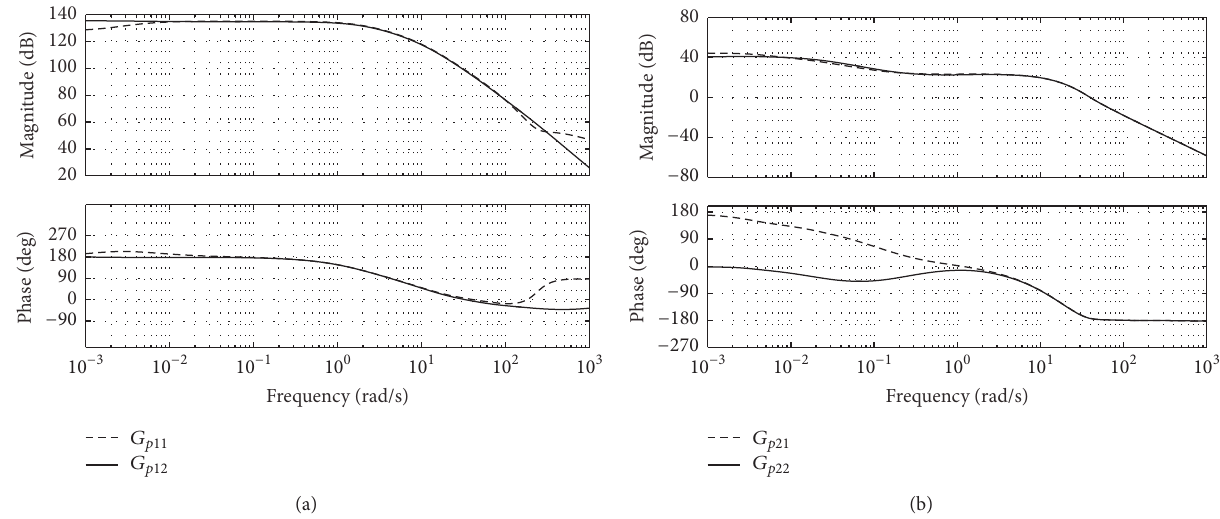
Figure 10: Bode diagram comparison (a) between 𝐺 𝑝11 and 𝐺 𝑝12 ; (b) between 𝐺 𝑝21 and 𝐺 𝑝22